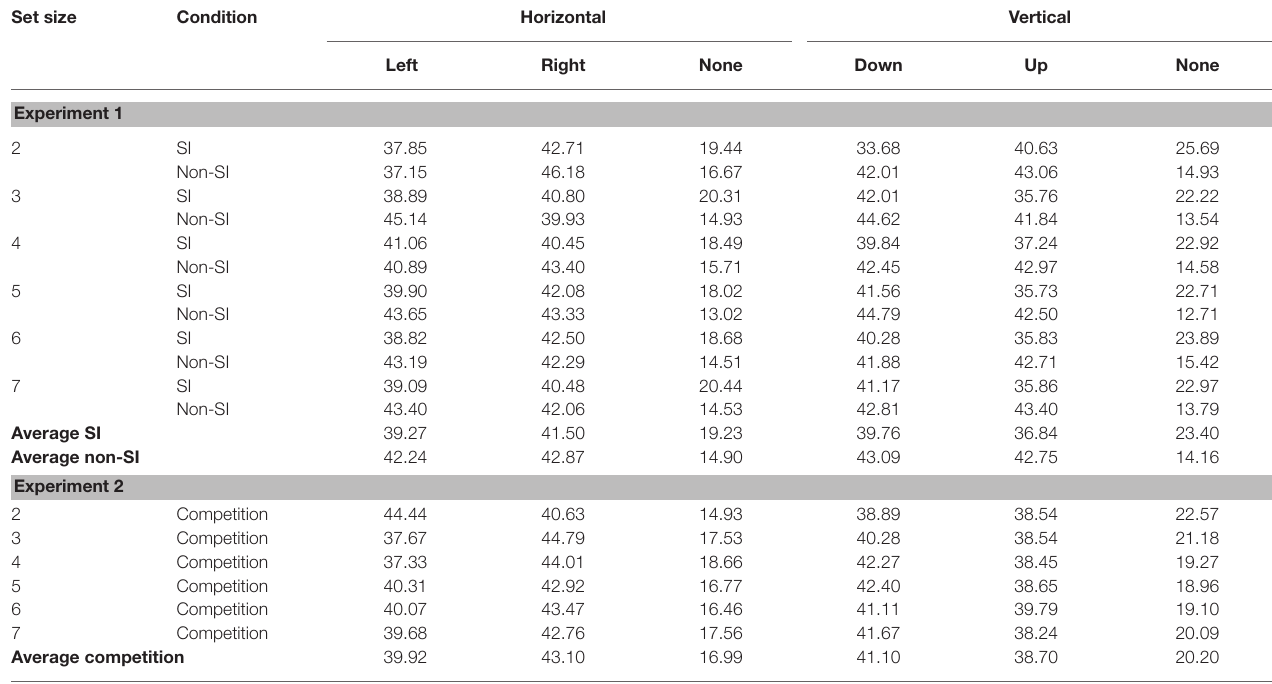
TABLE 2 | Percent of movement directions in the construction of the spatial sequences in Experiments 1 and 2, for each encoding condition and set size, separately for the horizontal and vertical axes. Set size Condition Horizontal